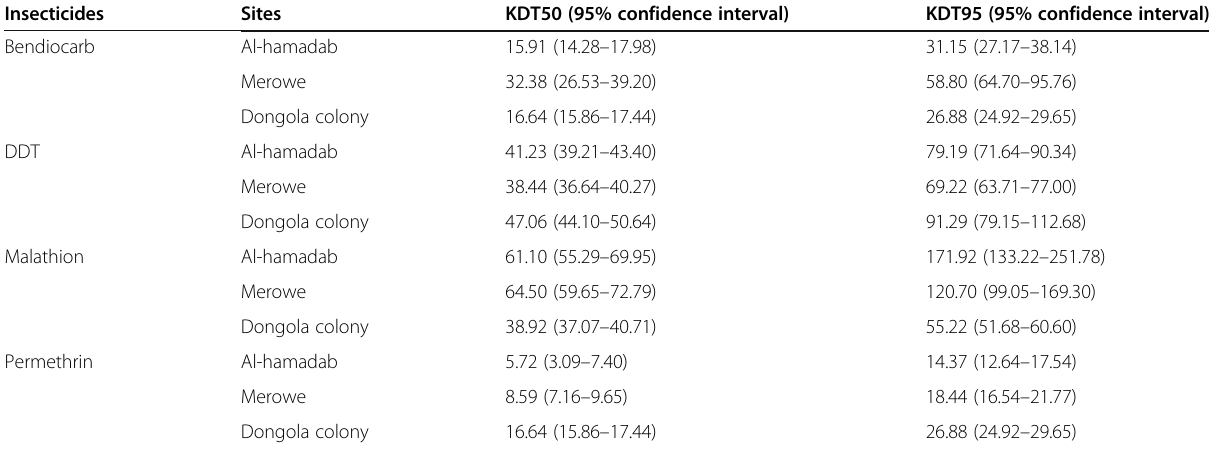
Table 4 Knockdown times (in minutes) (KDT50 and KDT95) of Anopheles arabiensis exposure to insecticides Insecticides